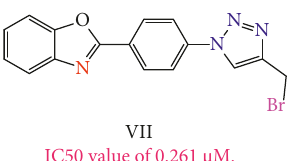
Figure 12: Aromatase inhibition activity of the of 2-substituted benzoxazole analogue (VII).